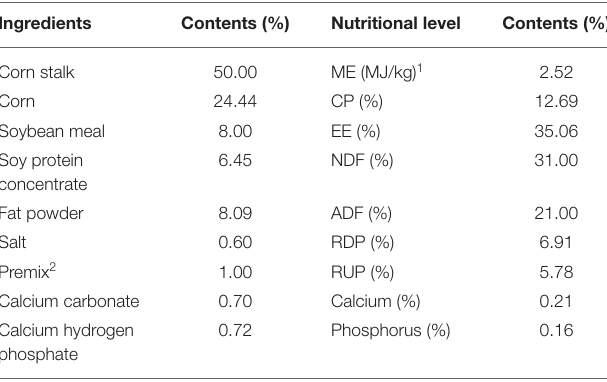
TABLE 1 | Ingredients and nutrient compositions of the experimental diet (DM basis).